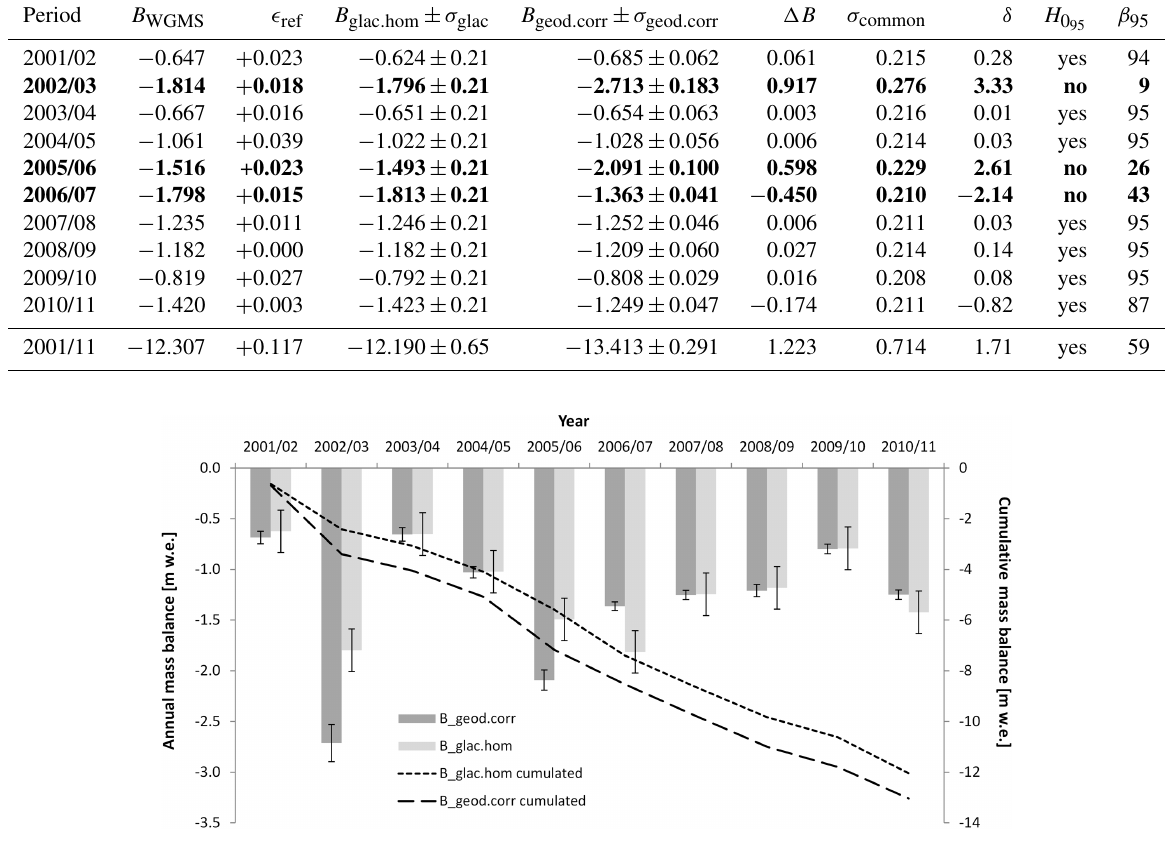
Figure 2. Comparison of the homogenized glaciological and corrected geodetic annual and cumulative mass balances of Hintereisferner over the study period. Dark grey bars and the dashed black line indicate geodetic balances, while light grey bars and the dotted black line show the glaciological series. Vertical black lines show the annual uncertainties ( σ glac and σ geod ) of the two